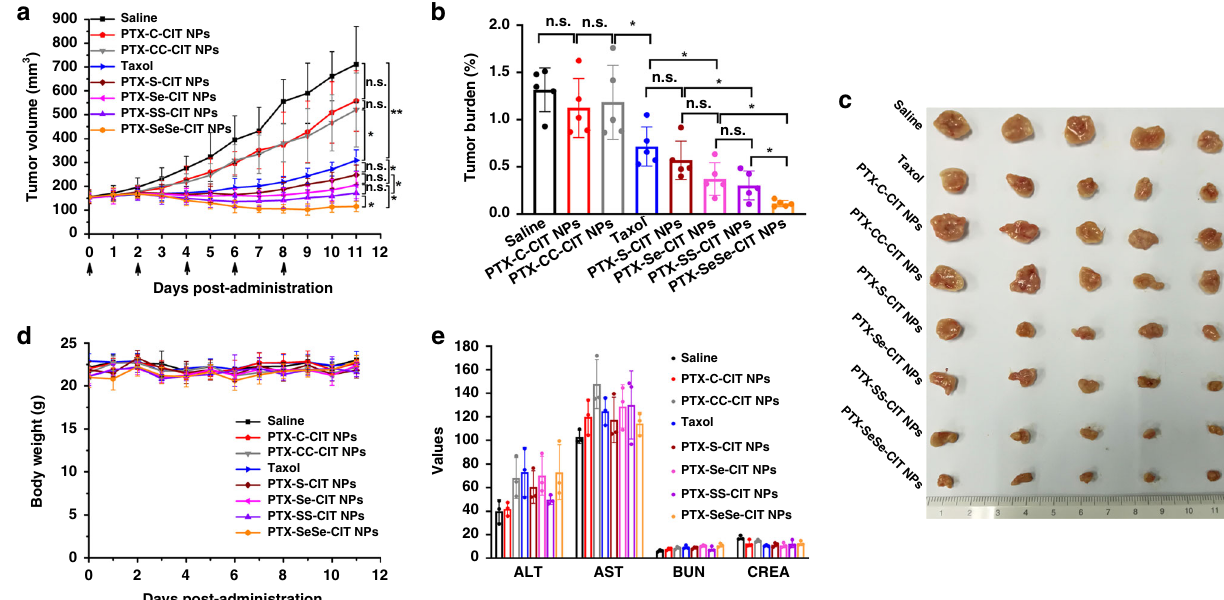
Fig. 5 In vivo antitumor ef fi cacy of prodrug nanoassemblies. ( a ) Tumor volume. ( b ) Tumor burden. ( c ) Images of tumors. ( d ) Body weight changes. Data are presented as mean ± SD ( fi ve independent experiments). * P < 0.05, ** P < 0.01 by two-tailed Student ’ s t test. ( e ) Hepatorenal function parameters. Data are presented as mean ± SD (three independent experiments). AST: aspartate aminotransferase (U L − 1 ); ALT: alanine aminotransferase (U L − 1 ),